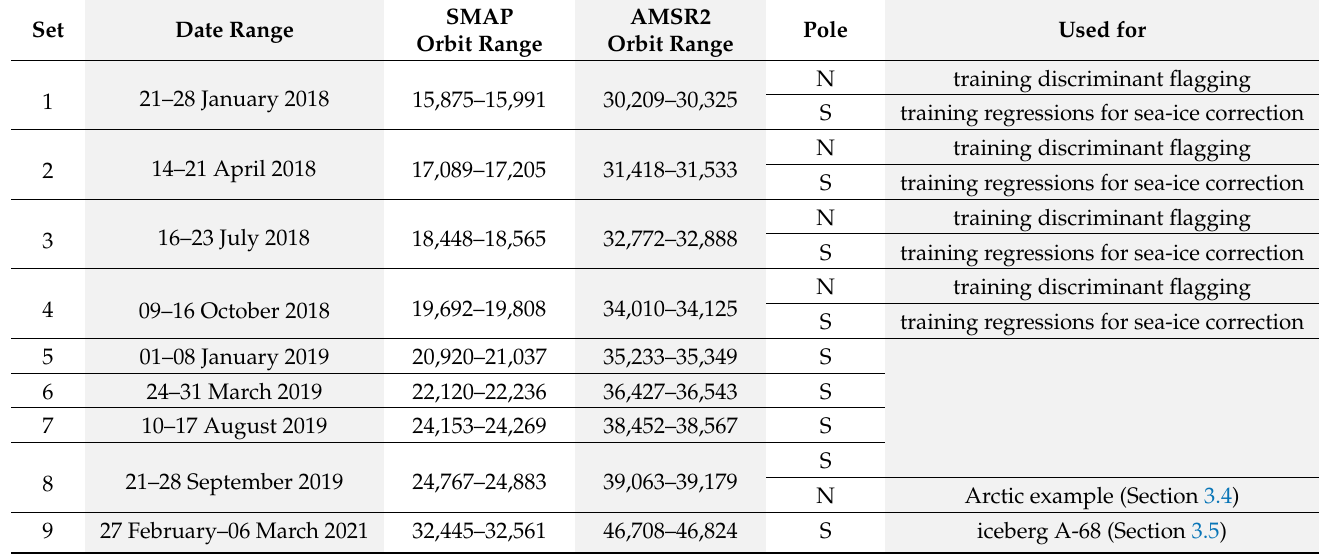
Table 1. Date and orbit ranges for the 8-day SMAP and AMSR2 TB data sets that are used for training and testing the sea-ice flagging and sea-ice correction